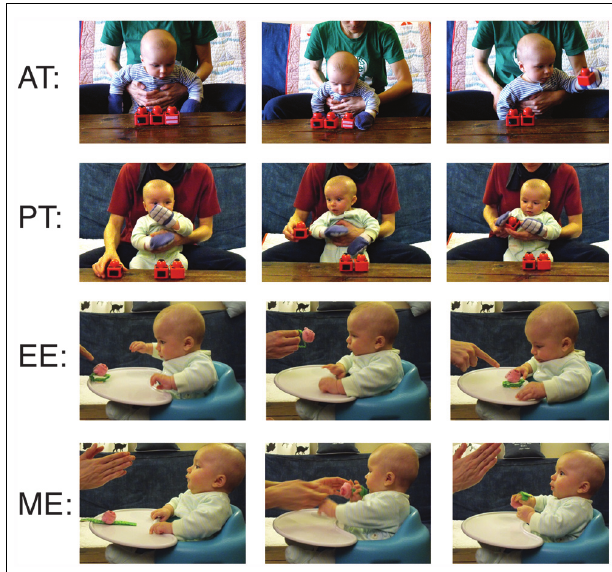
FIGURE 1 | Example of training procedures. Active training (AT) – Infants wear “sticky mittens” allowing them to independently pick-up Velcro-covered toys. Passive training (PT) – Infants wear mittens without Velcro, parents lift and touch toy to infant’s palm. Encouragement experience (EE) – Parent draws attention to a small toy within reach of the infant, but does not help infant grasp toy. Movement experience (ME) – Parent engages infant but does not talk about or draw attention to toy, parent attached toy to infant’s hand without drawing attention to toy. Figure adapted from Libertus and Needham (2010,